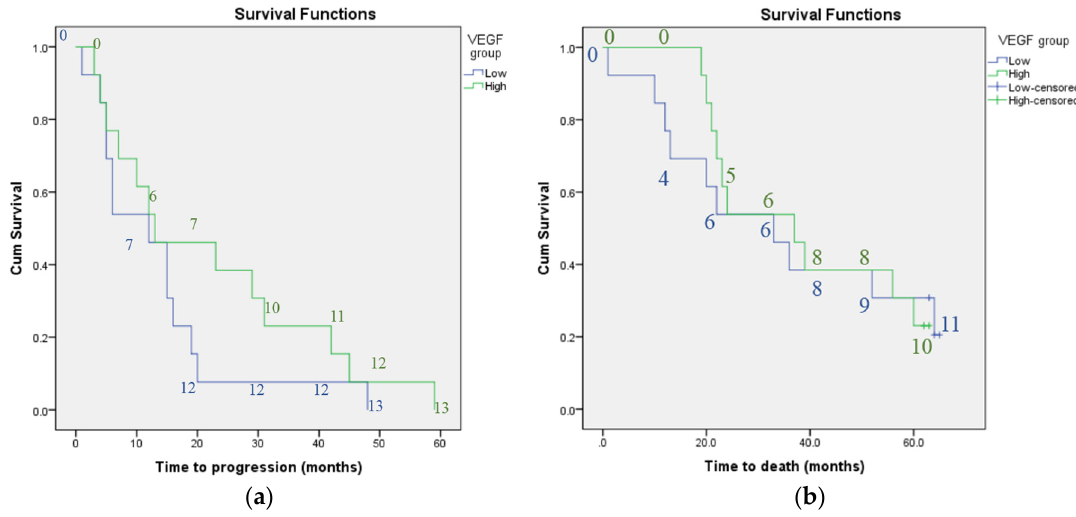
Figure 1. Kaplan ‐ meier curves: survival in terms of: ( a ) disease progression and ( b ) mortality according to baseline plasma VEGF concentration; Kaplan ‐ meier curves showing no significant difference in survival as measured by progression of lung disease or mortality according to baseline plasma VEGF concentration; Key: low = baseline plasma VEGF concentration less than group median; high = baseline plasma VEGF concentration greater than group median.